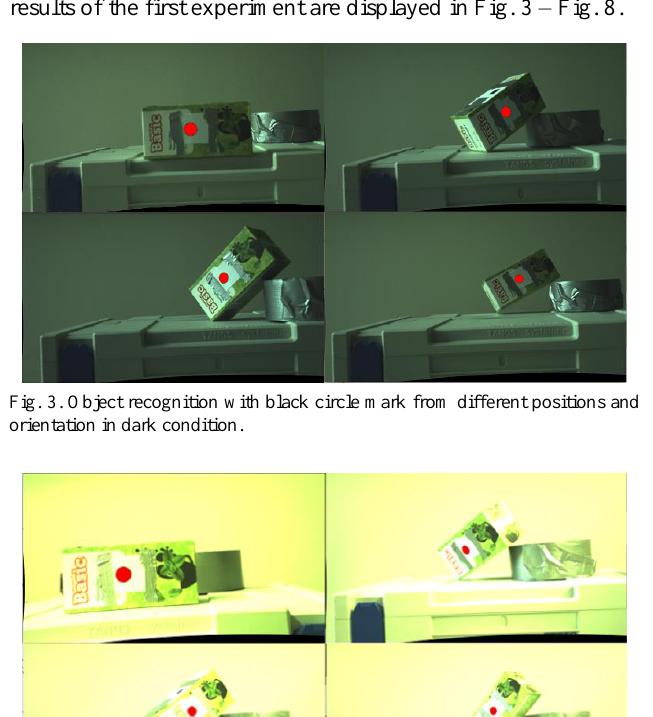
Fig. 6. Object recognition with a mark of colored image from different positions and orientation in a bright light condition.